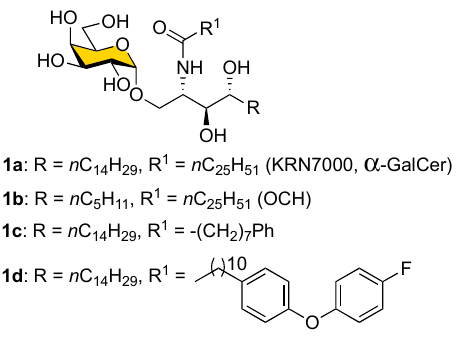
Figure 1. Structures of α -galactosylceramide (KRN7000, 1a ) and its analogs ( 1b – 1d ). Many structural analogs of α -GalCer based on the modification of KRN7000 were found to be potent immunomodulatory agents that act by CD1d-dependent iNKT cell stimulation [12]. SAR studies of α -GalCer analogs include two major classes of modification; variation in the hydrophilic polar carbohydrate head group that directly interacts with the T-cell antigen receptor (TCR) and variation in the acyl chain and the sphingoid base structures of the ceramide (Cer) moiety responsible for CD1d binding [13]. The long fatty acyl chain (C26:0) and phytosphingosine (Psp) chain of the Cer moiety in α -GalCer interact with many amino acid residues in the hydrophobic lipid-binding grooves of CD1d, A’ pocket and F’ pocket, respectively, resulting in the formation of a stable glycolipid–CD1d binary complex [6,14]. Thus, the fatty acyl chain of α -GalCer plays an important role in eliciting selective cytokine production. For example, an α -GalCer analog with a shorter length of Psp of Cer, commonly referred to as OCH ( 1b ), switches the activity to a more selective T H 2 response [15]. In addition, the introduction of double bonds, such as di-unsaturated C20 fatty N -acyl chain (C20:2) α -GalCer analog, leads to a bias toward T H 2 responses [16]. Further introduction of a phenyl (such as 1c ) [17] or para -fluoro phenyl ring to the fatty acyl chain strongly enhances the production of T H 1 cytokines and has been demonstrated as a prototype for adjuvant development [18]. Longer hydrophobic lipid chains of Psp also selectively induce T H 1 cytokines [19]. A polar amide group on the truncated fatty acyl chain of α -GalCer retains binding to CD1d and T H 2-selective cytokine production [20]. Moreover, a T H 1-selective CD1d-binding iNKT cell ligand, C34 ( 1d ), bearing a nonpolar para -F substituted aromatic moiety in the lipid chain, was reported; it is also used as an adjuvant in breast cancer vaccines [21]. The stereochemistry of Psp was also reported to be important for the activity of α -GalCer. The change of chiral center of 2 S , 3 S , 4 R -Psp resulted in loss or a significant decline in CD1d protein binding activity [22]. Further exploration of modifications of the pyranose ring, carba-analogs of α -GalCer [23], and 5-S-KRN7000 [24], and enzymatic hydrolysis-resistant glycolipids, such as α - C -GalCer [25], show potential in stimulating innate immune responses in mice that are biased toward induction of T H 1 responses. A diether-containing α -GalCer analog was reported to show Th17 selectivity with improved IL-17 secretion